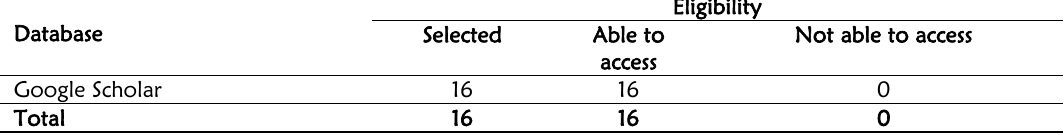
Table 11: Numbers of articles available in Google Scholar (additional